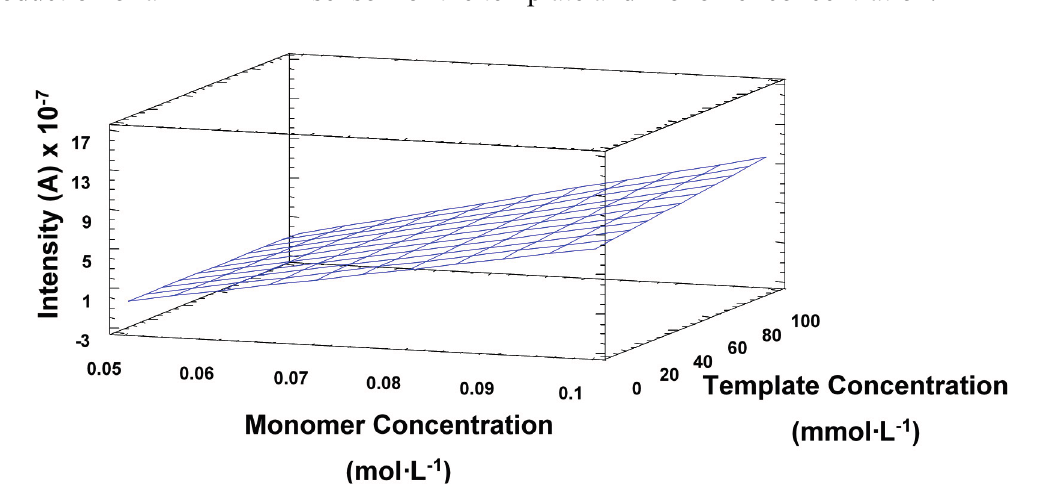
Figure 4. Representation of the surface response of the optimization process for the production of a TATP-MIP sensor for the template and monomer